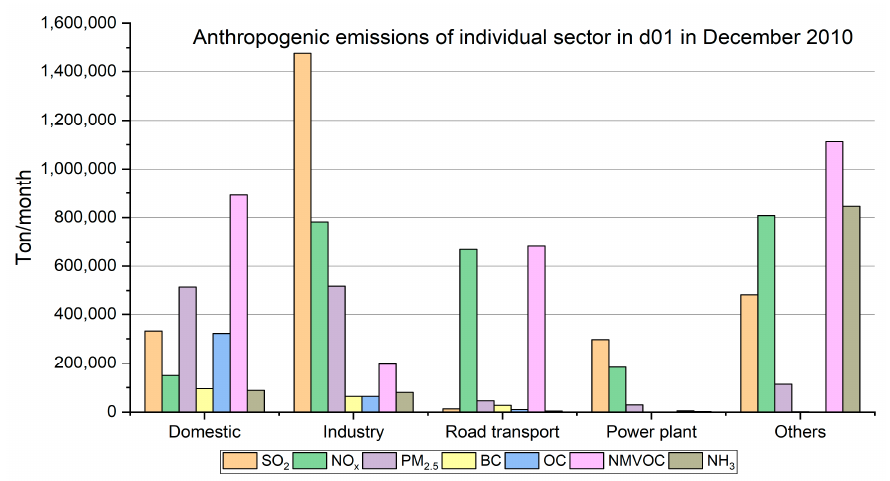
Figure 3. Anthropogenic emissions of individual sector in d01 in December 2010.